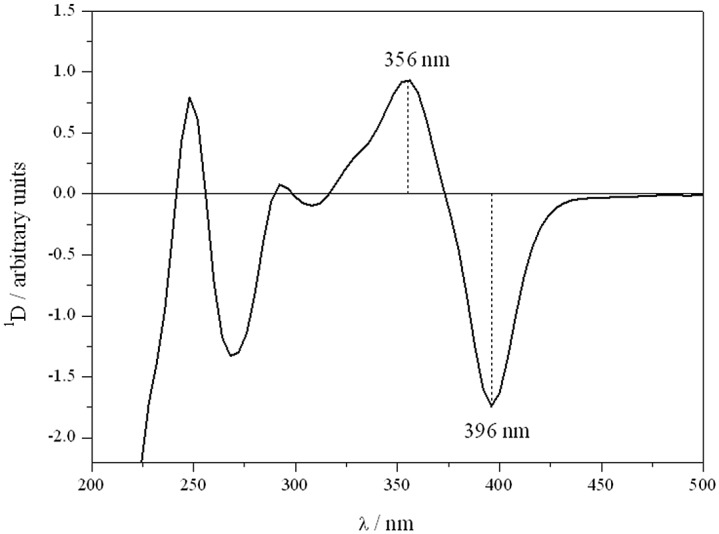
First derivative absorption spectrum of quercetin.